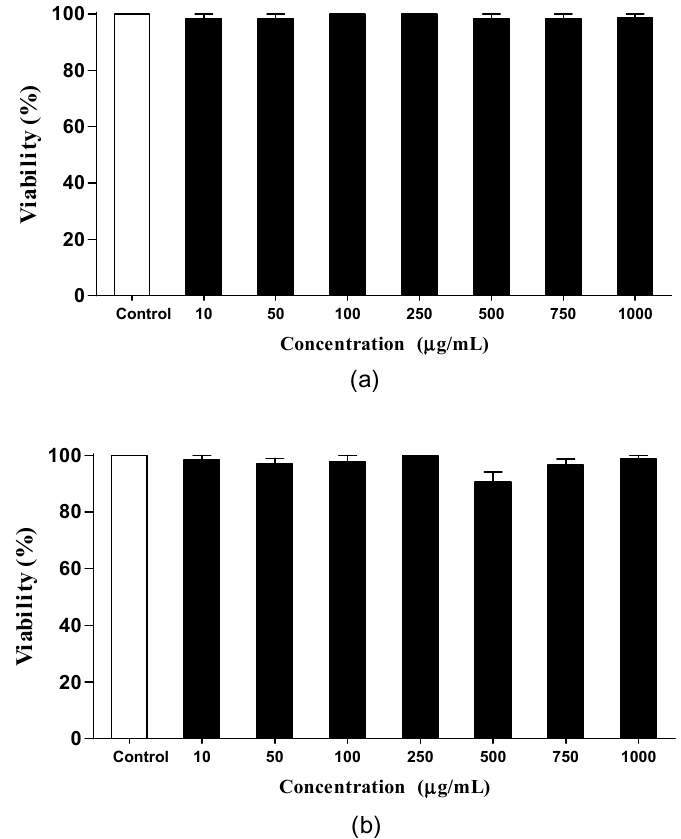
Figure 2. Toxicity of FPDA to C. elegans for ( a ) 24 h and ( b ) 48 h. Values are expressed as the mean ± SEM.